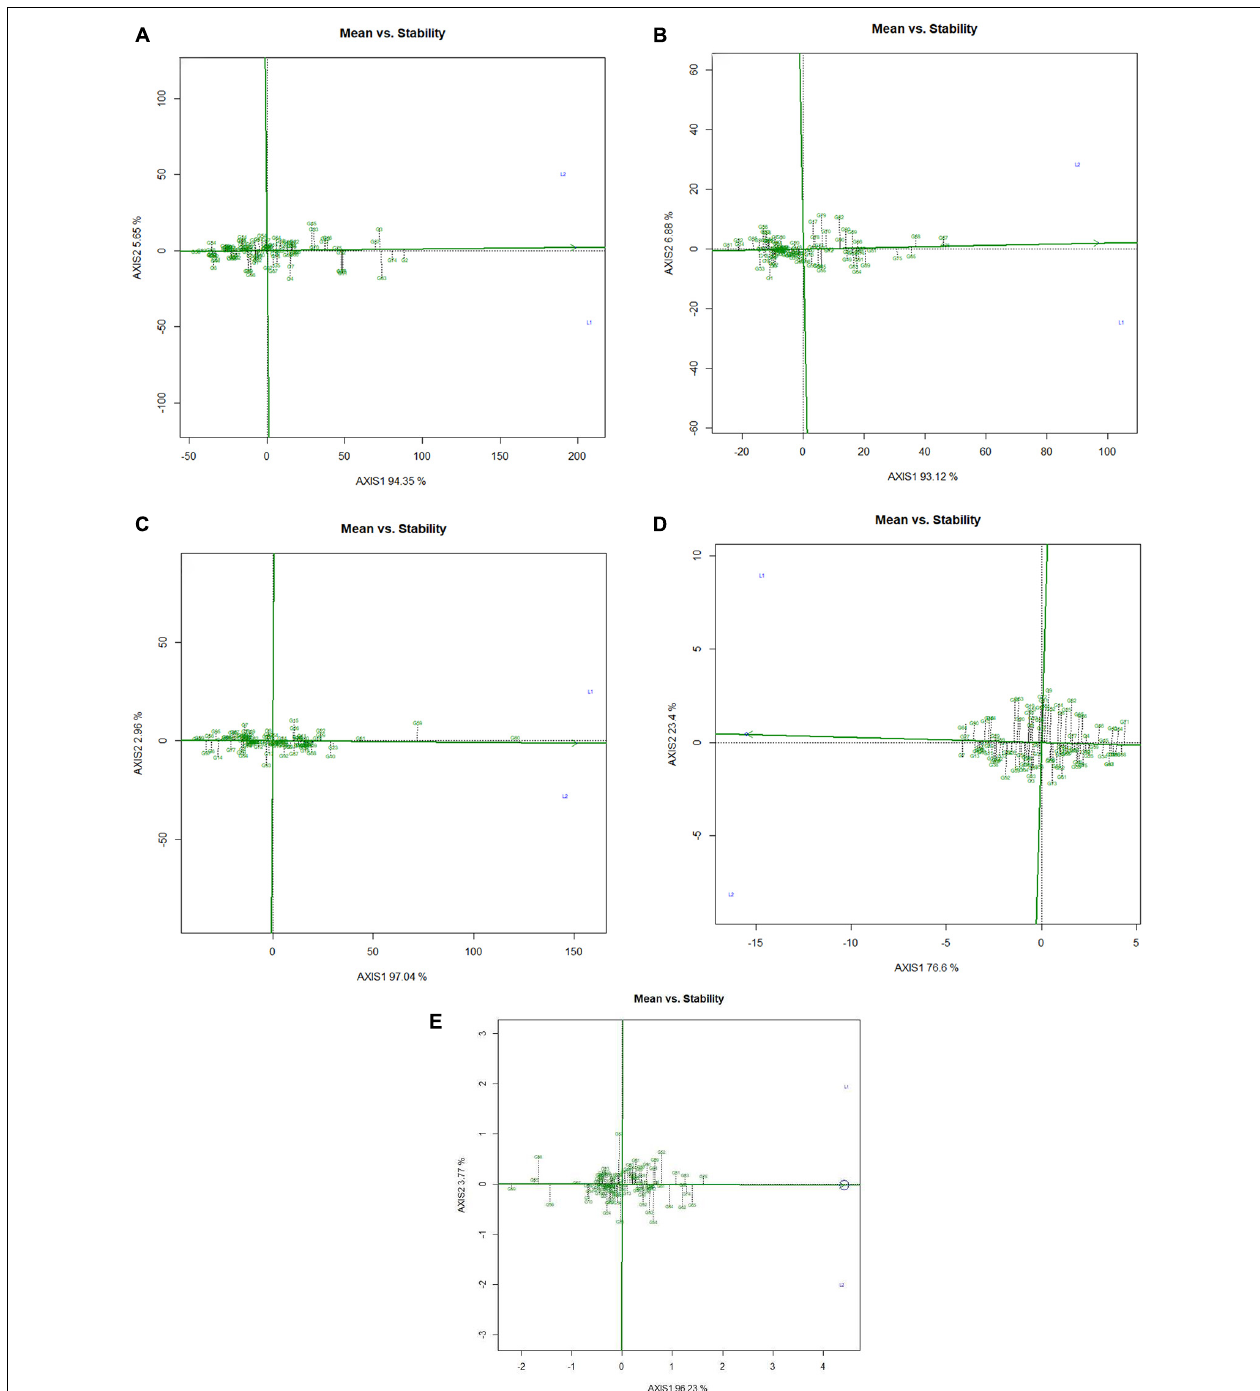
FIGURE 4 | Mean vs. stability view of the GGE biplot over two locations. There was no transformation of data (transform = 0), and data were centered by means of the environments (centering = 2). The biplot was based on ‘row metric preserving.’ Numbers denote the serial numbers of genotypes as listed in Supplementary Table S1 . Loc1 – ICAR-IIPR, Kanpur and; Loc2 – ICAR-NBPGR, New Delhi. (A) Mean vs. stability view of the GGE biplot regarding Fe concentration over two locations. (B) Mean vs. stability view of the GGE biplot regarding Zn concentration over two locations. (C) Mean vs. stability view of the GGE biplot regarding Ca concentration over two locations. (D) Mean vs. stability view of the GGE biplot regarding protein concentration over two locations. (E) Mean vs. stability view of the genotypes regarding phytate concentration over two locations.